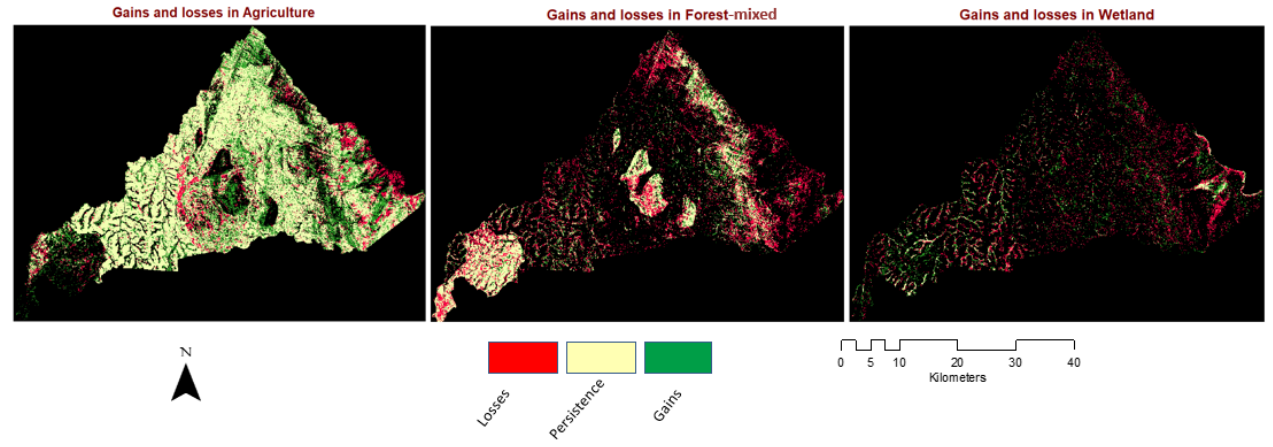
Figure 6. Maps of land gains, persistence, and losses for agriculture, forest-mixed, and wetland classes in Dedza district (2001–2019 period) (black pixel colors contain no information).